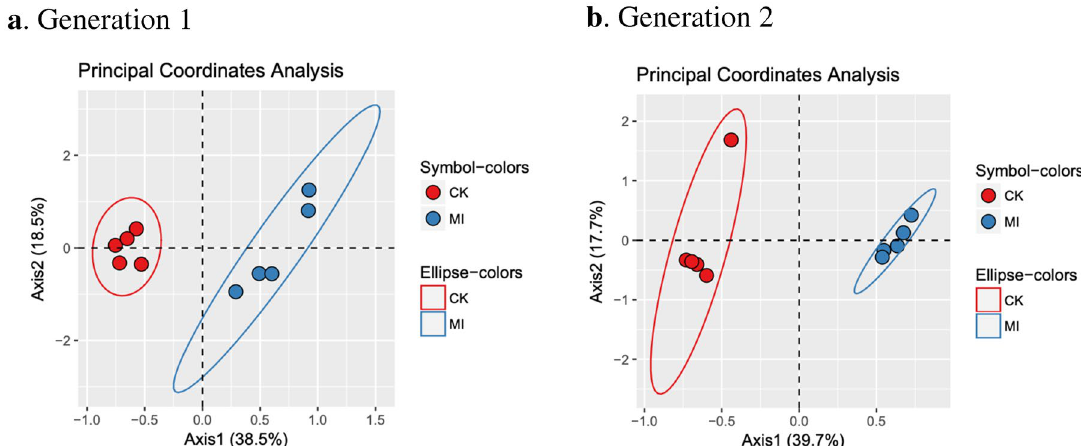
Figure 2. Principal coordinates analysis (PCoA), using Bray–Curtis distances, representing rhizobacterial communities of soil samples from control and microbial inoculation treatments (n = 5 soil samples per water treatment) within generation 1 ( a ) and generation 2 ( b ). Red and blue circles represent control (CK) and microbial inoculation (MI) treatments,